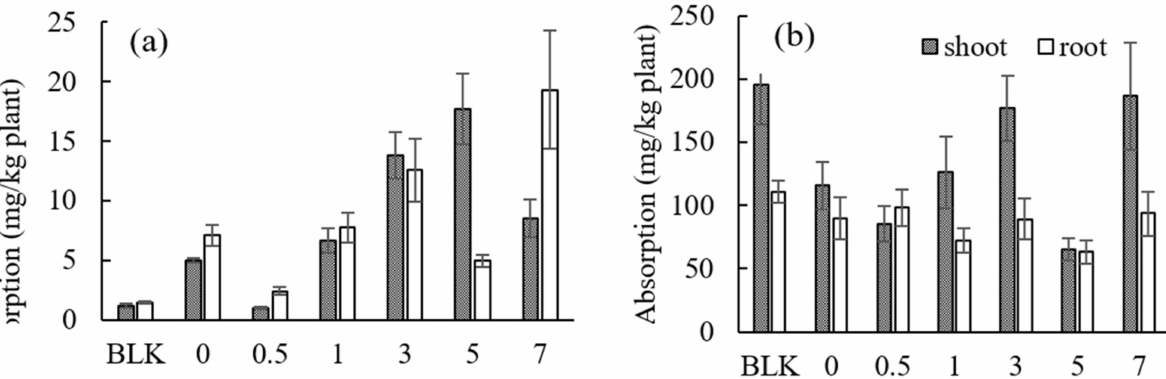
Figure 8. Effect of the EDDS concentration on the absorption of ( a ) Cd and ( b ) Zn by Gazania (70% humidity). BLK represents the pot for no addition of heavy metals (i.e., Cd and Zn) as well as no addition of EDDS (i.e., Pot No. 1 in Table